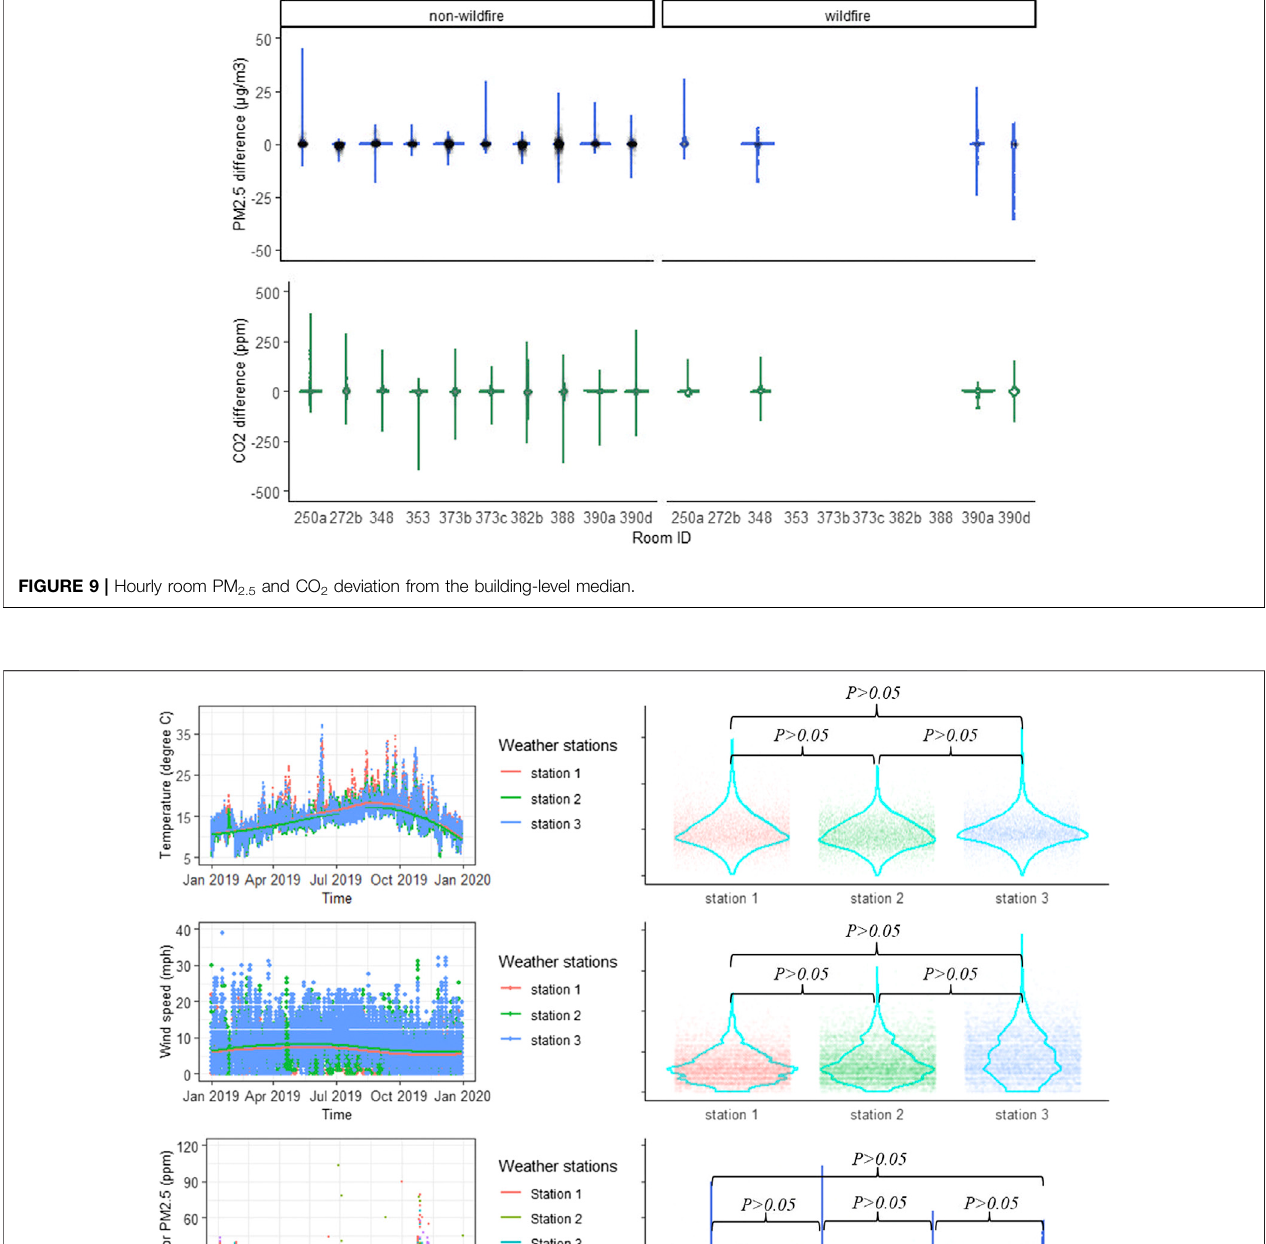
Frontiers in Environmental Science |